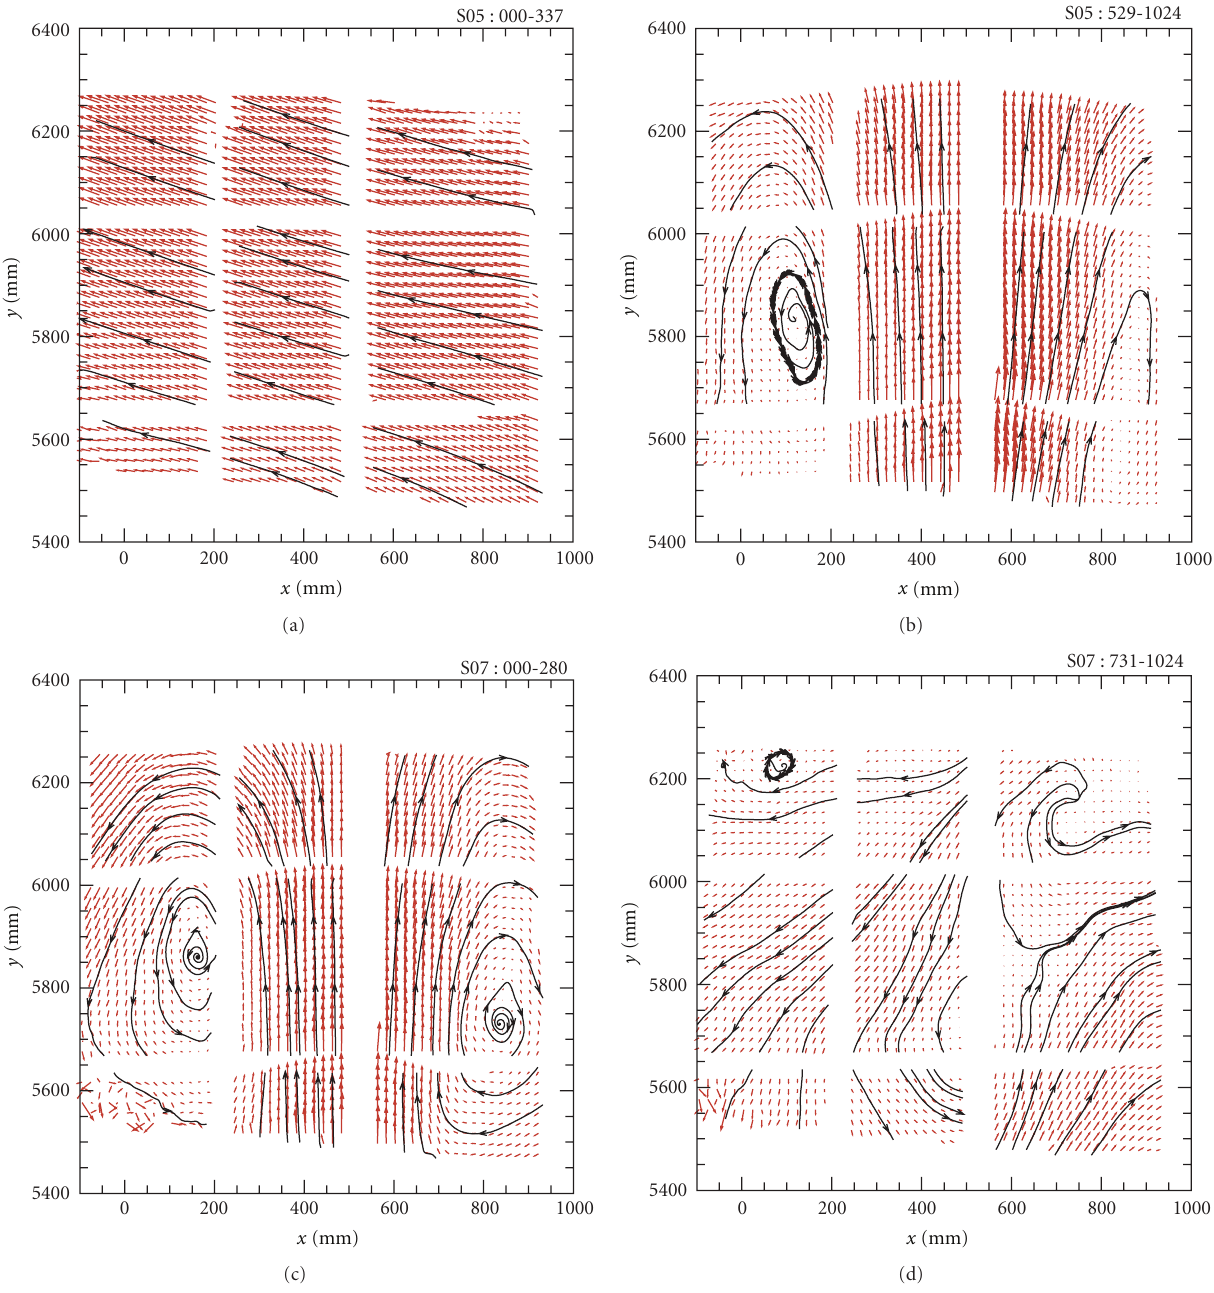
Figure 20: Selected mean velocity fields for ST4 1 for (a) 5410 s < t < 5560 s, (b) 5656 s < t < 5904 s, (c) 8444 s < t < 8500s, and (d) 8590 s < t < 8649